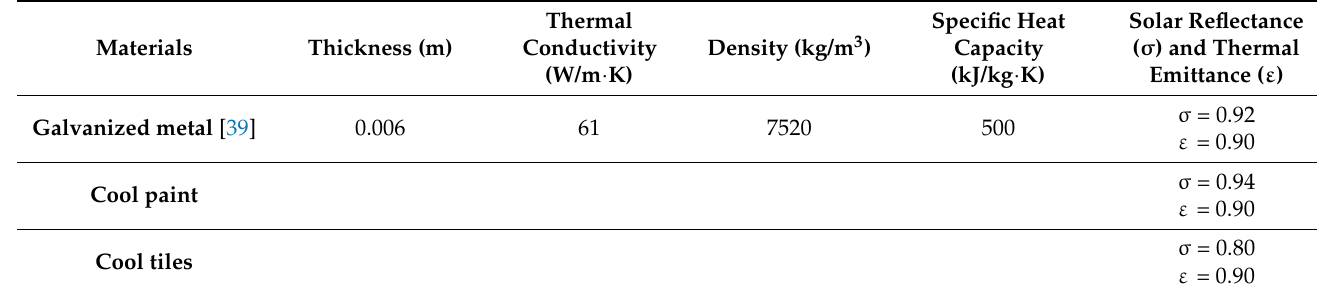
Table 2. Thermo-physical properties of the materials used in the passive cooling